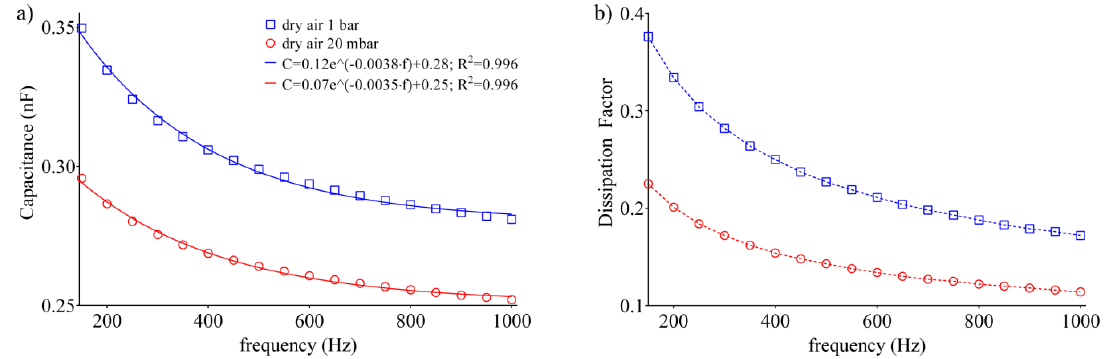
Figure 6. Relationship inside the vacuum chamber at 20 mbar and 1 bar dry air saturated environment of: ( a ) electric capacitance vs. frequency; and ( b ) dissipation factor vs. frequency.